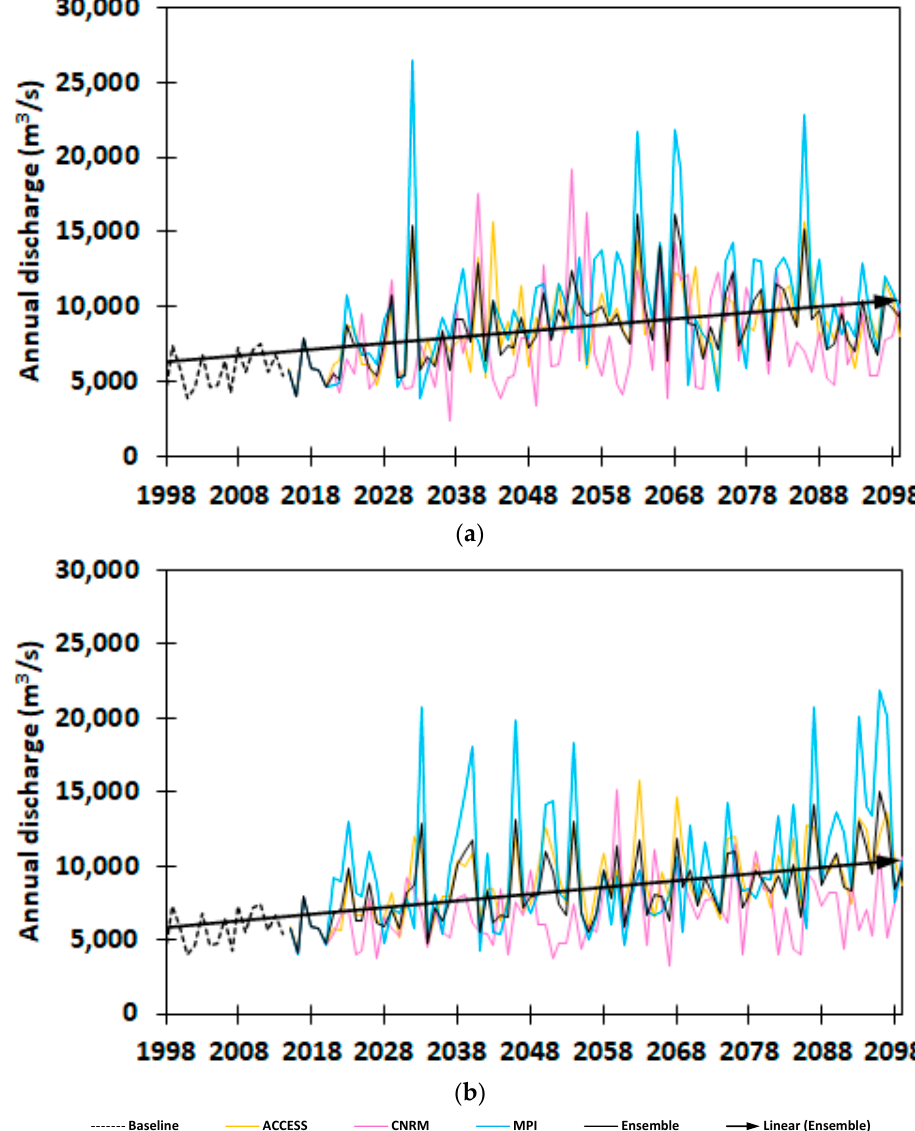
Figure 7. Projected annual discharge at Pitabaddara under ( a ) RCP4.5 and ( b ) RCP8.5 for ACCESS, CNRM and MPI RCMs.